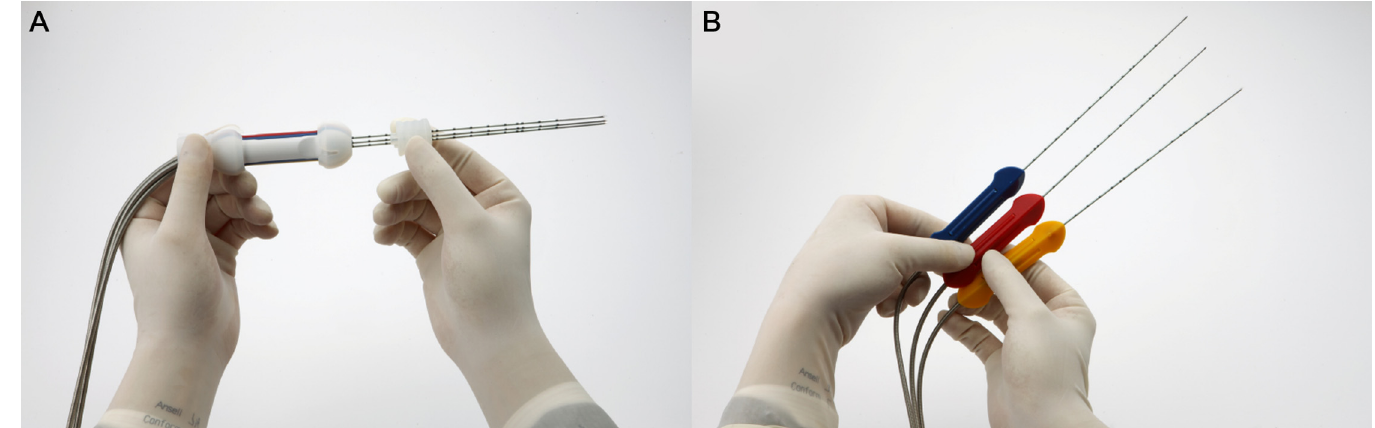
Fig 2. Diagram of the “ no-tumor-touch ” technique to ablate a 1.5 cm sized